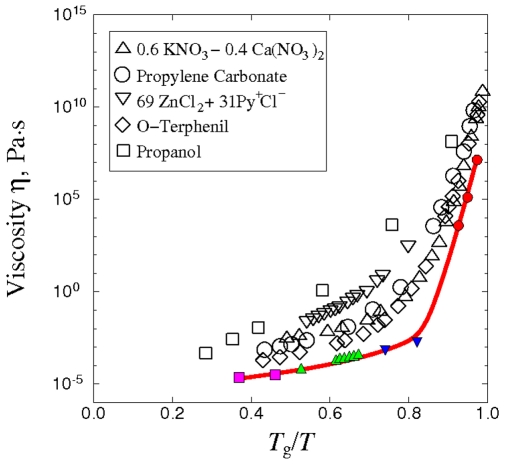
Experimental validation of the Network model.Solid line indicates the viscosity of BLJ liquid calculated by the Network model. Symbols are experimental data on fragile glass formers [3].